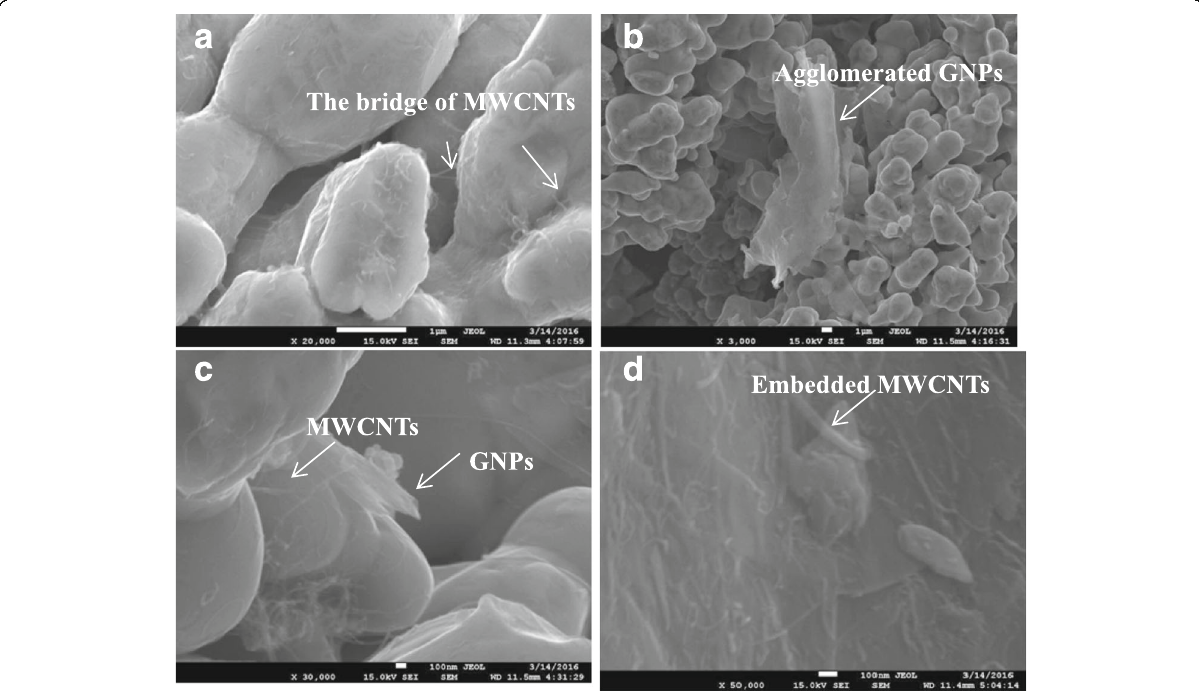
Fig. 1 SEM images of raw materials of Cu, Ti 3 SiC 2 , C, MWCNT, and graphene powders after ball milling, taken at a low magnification ( b ) and a high magnification ( a , c , d ). a – c Nanocomposites with 0.5 wt% graphenes and 0.5 wt% MWCNTs. d Nanocomposites with 0.8 wt% graphenes and 0.2 wt%